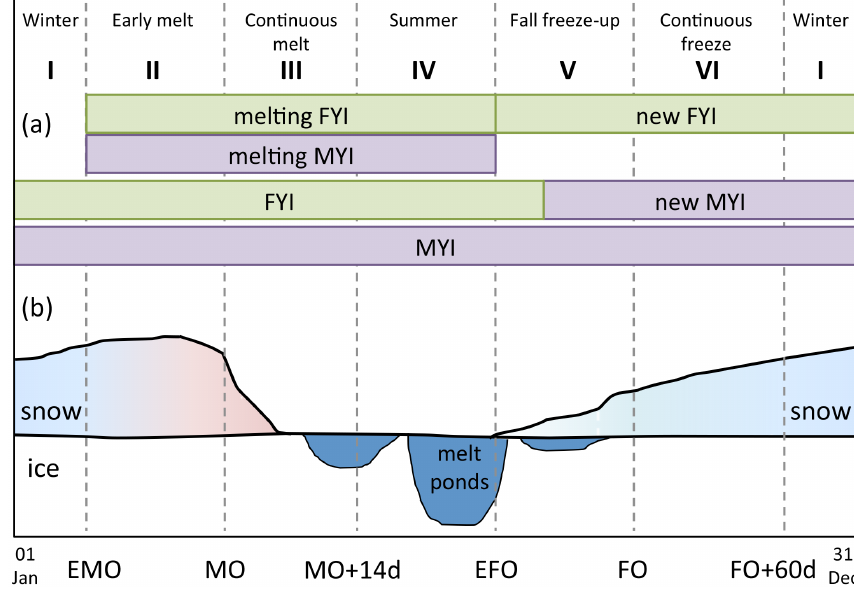
Figure 1. Classification of sea ice (a) types and (b) surface properties as used in this study. The timing of each phase results from the status of the sea ice. Depending on the season, different sea ice types co-exist. Abbreviations: FYI: first-year ice; MYI: multi-year ice; EMO: early melt onset; MO: melt onset; EFO: early freeze onset; FO: freeze